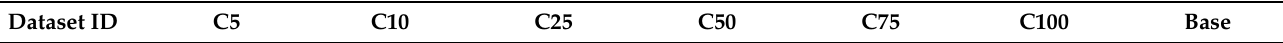
Table 3. Performance comparison of sequencing over different clusters of the annual demand.